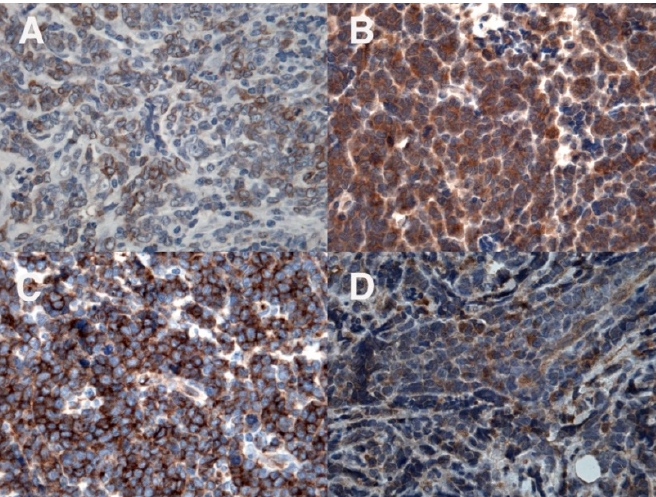
Figure 4. Immunohistochemical evaluation: positivity for the myeloid marker MPO ( A ); in addition, positivity for CD33 ( B ), CD34 ( C ), and CD117 ( D ). Table 1. Therapy courses according to the S2 group/arm B of the AIEOP ALL REC/2003 trial. Our patient received the following chemotherapy: phase IA-IDA, R2 block, R1 block, R2 block, R1 block, R2 block, R1 block, maintenance.